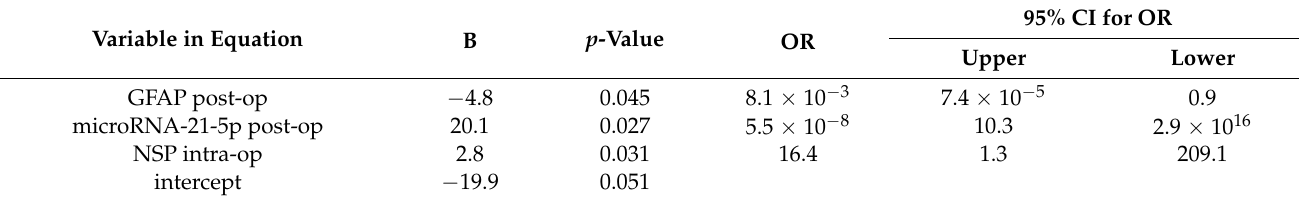
Table 3. Multivariable logistic regression of predictors for ePOCD.